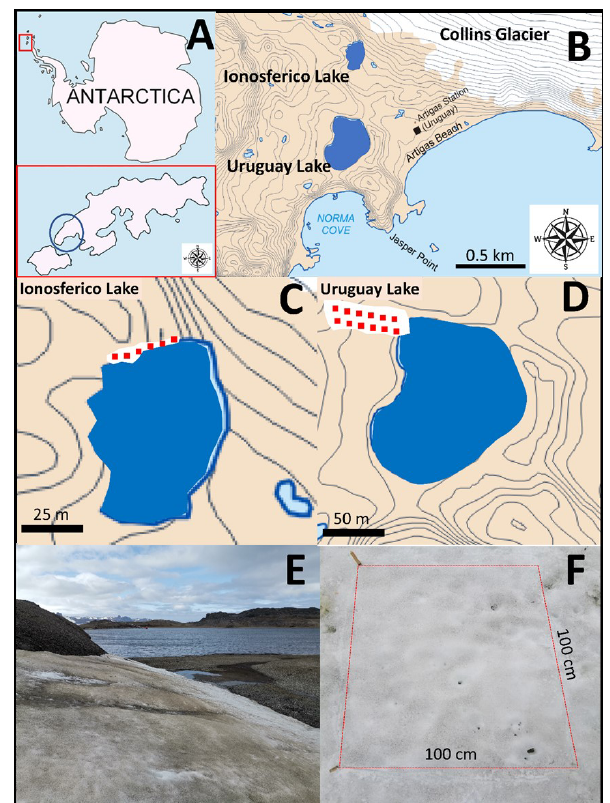
Figure 1. (a) General view of Antarctica and location of King George Island. The blue ellipse indicates the Fildes Peninsula. Collins Glacier is located in the northeast of Fildes Peninsula. (b) A detailed view of Ionosferico Lake, Uruguay Lake, Artigas Re- search Station and Collins Glacier in the Fildes Peninsula. Pan- els (c) and (d) show the ablation zone of Collins Glacier around Ionosferico Lake and Uruguay Lake, respectively. Red squares indi- cate sampling squares. (e) Photograph of the glacier surface around Uruguay Lake that constitutes part of the ablation zone of Collins Glacier taken on 18 February 2020. (f) A representative square on the glacier surface used in this